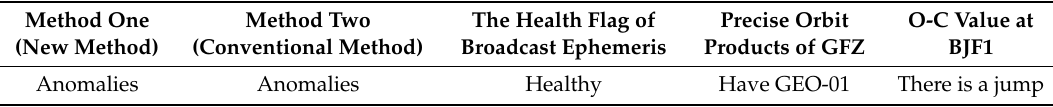
Table 4. Results of GEO-01 anomalies detection at 18:00–19:00.